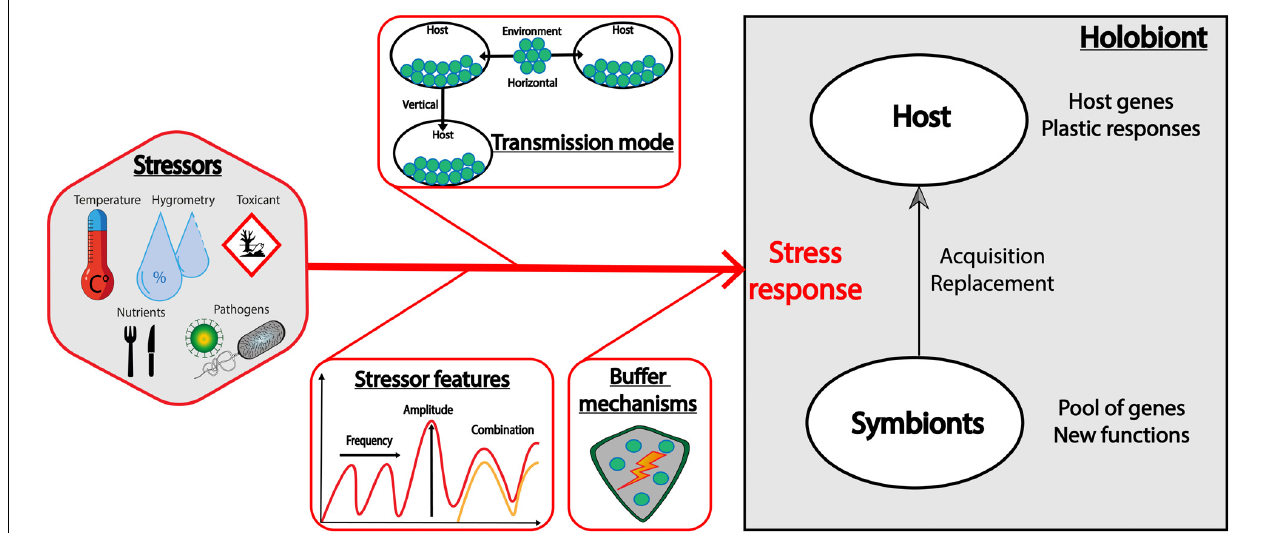
FIGURE 2 | Factors that can influence the holobiont stress response. The holobiont response to stressors is difficult to predict as many factors can be under selection. This includes host resistance genes and plastic mechanisms, but also acquisition of symbionts that can constitute a pool of genes with new functions. We describe here some key factors that can preferentially select for the host or the symbionts to adapt to stressors: (1) the features of the stressor, such as its frequency or amplitude, but also its combination with another stressor that can lead to an additive, synergistic or antagonist interaction, (2) the transmission mode of the symbionts, and (3) the specificity and the efficiency of the given buffering mechanism, and the net balance between its cost and its